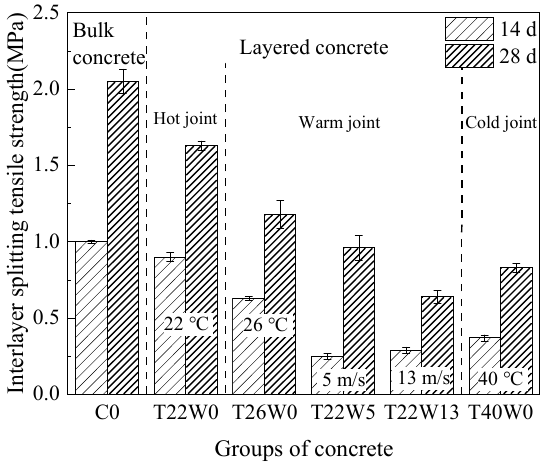
Figure 6. Comparison of interlayer splitting tensile strength in different layer states.